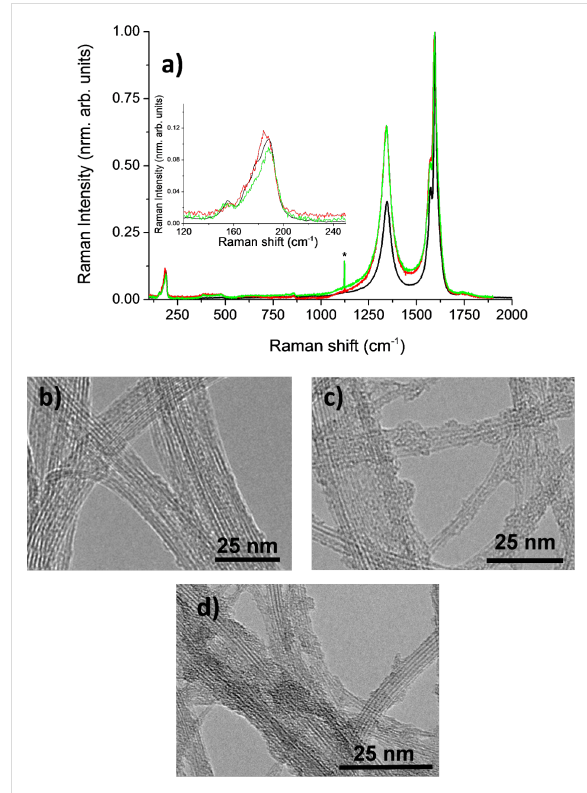
The SWNTs functionalized under 5 min or 10 min of microwaves could be well dispersed leading to dark solutions. Figure 2: Raman spectra of the starting and functionalized SWNTs